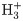
Effects of 2′- and 3′-modifications on G binding to the Azoarcus ribozyme.Equilibrium binding constants (Kds) were obtained as described in Materials and Methods. (A,C) The effects of 2′-NH2 and 2′-H substitutions on G binding to E (A) and ES (C). Values for binding of G represent the mean equilibrium binding constant from several independent measurements at different pH values at 15 mM Mg2+ in the absence or presence of 10 mM Mn2+ (S1 and S2 Figs). Values for binding of G(2′NH2) are derived from the fit to the model shown in S4–S6 Figs. The value for binding of G(2′NH2) to ES in the presence of Mn2+ represents the mean equilibrium binding constant from several independent measurements (S7 Fig). The fits to determine the Kd for G(2′H) are shown in S10 Fig. (B,D) The effects of 3′-NH2 and 3′-H substitutions on G binding to E (B) and ES (D). Values for binding of G at 15 mM Mg2+ were obtained as described above. Values for binding of G(3′NH2) were derived from the fit to the model shown in S8 and S9 Figs. Measurements were made at 100 mM Mg2+ to attenuate strong binding of G(3′NH3+) (Materials and Methods). The arrows for the binding constants of G(3′NH2) denote that the observed Kds are lower limits (S8 and S9 Figs). Raising the Mg2+ concentration to 100 mM had a negligible effect on binding of G (S3 Fig), so that the affinities of G(3′NH2) can be compared with binding affinities for G at 15 mM Mg2+. The fits to determine the Kd for G(3′H) are shown in S10 Fig.